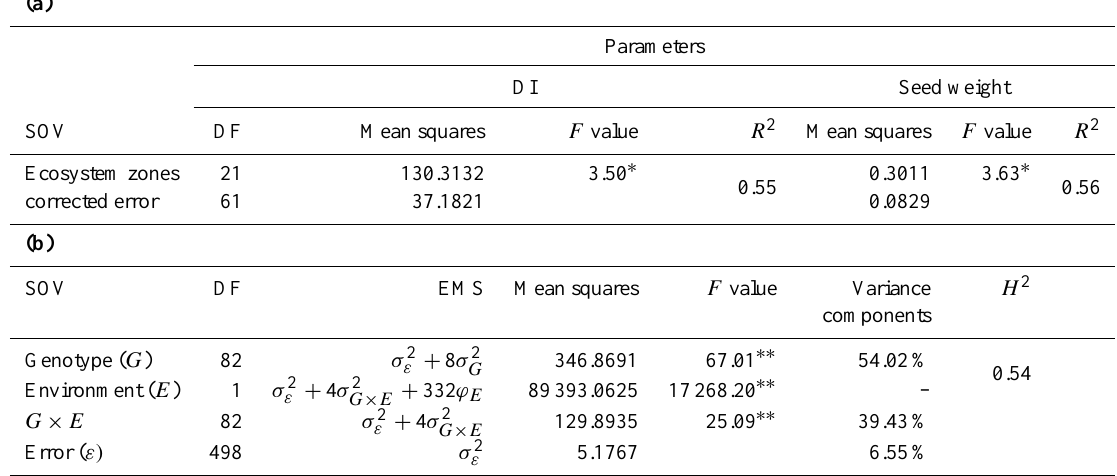
Table 2. Multi- and uni-variate analyses for life-history traits. (a) MANOVA table reporting the correlation of seed dormancy (DI) and weight with ecosystems; (b) ANOVA table reporting significant effect of the genotype on phenotypic variance and associating broad-sense heritability ( H 2 ) .